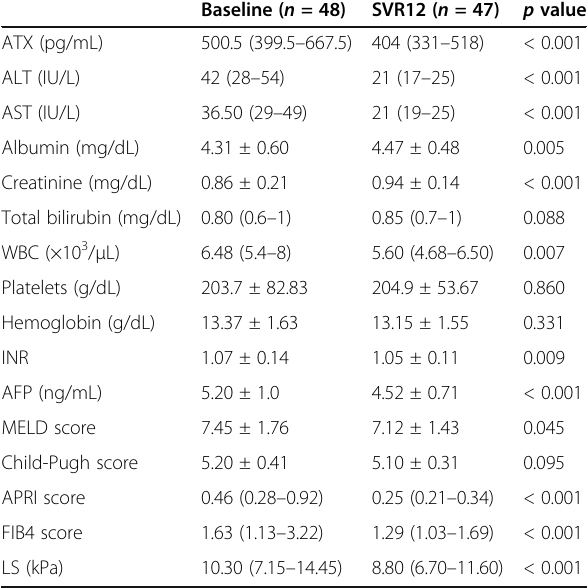
Table 1 Patients ’ characteristics at baseline and SVR12 Baseline ( n = 48)